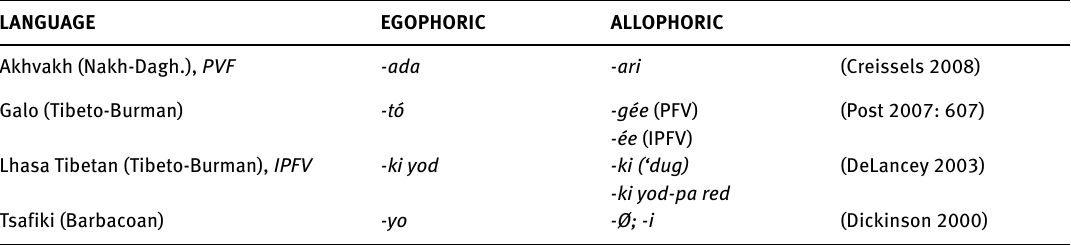
Table 1. Paradigms of simple egophoric marking systems